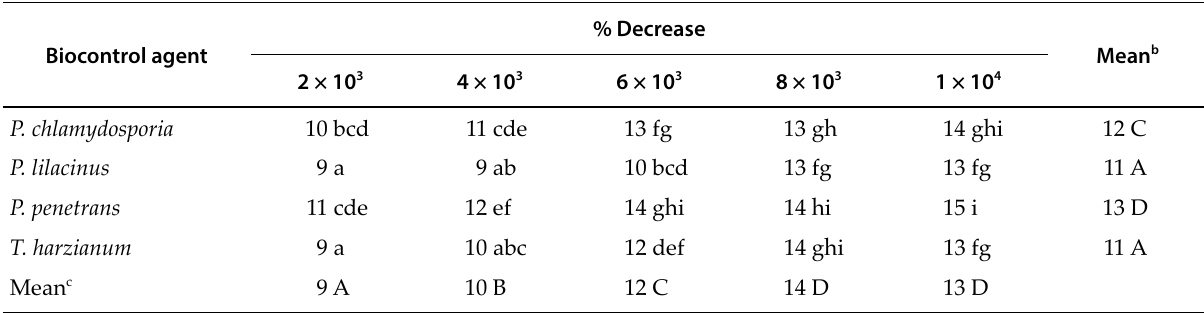
Table 3. Mean proportional decreases in root weights of okra plants after treatments with different nematode biocontrol agents applied at different propagule concentrations.